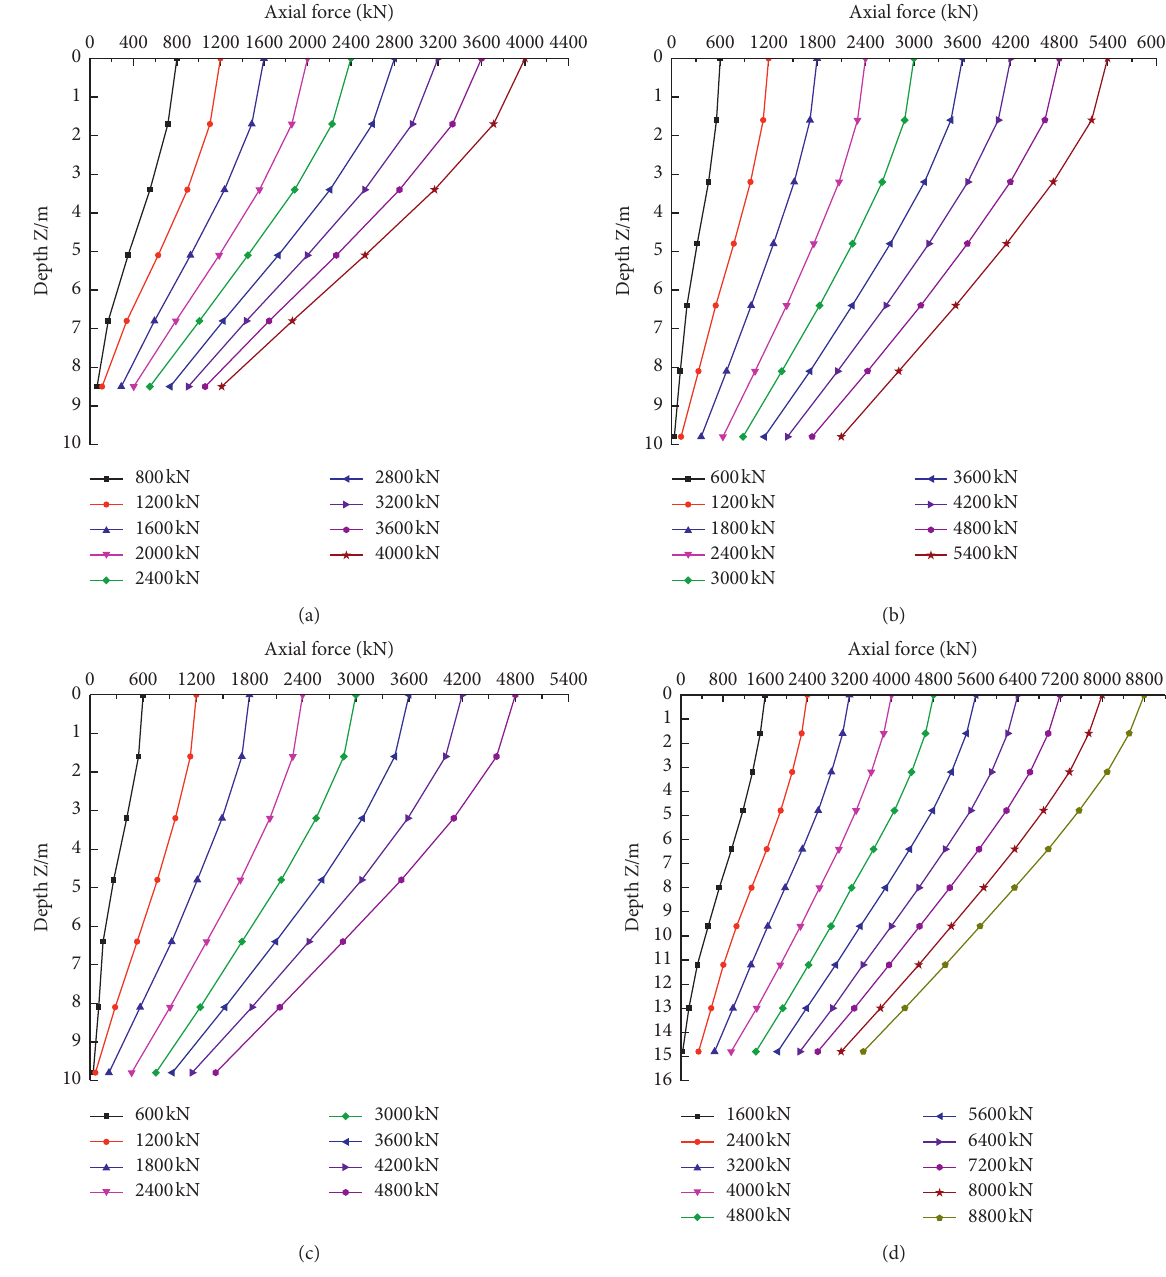
Figure 10: Distribution curve of axial force of each pile. (a) No. 1 pile. (b) No. 2 pile. (c) No. 3 pile. (d) No. 4